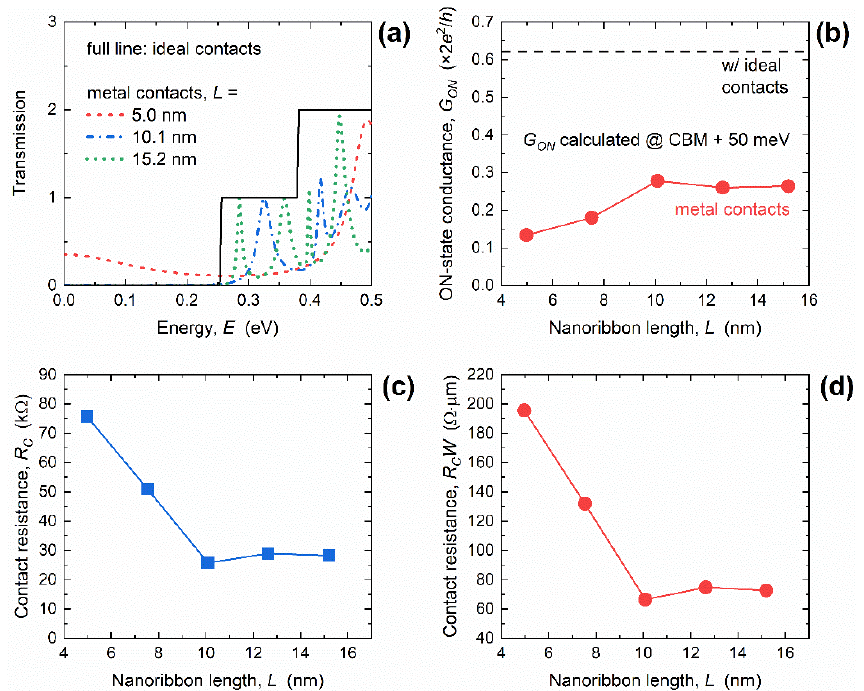
Figure 6. ( a ) Length-dependent transmission in GNRs with ICs and MCs. Impact of length scaling on ( b ) ON-state conductance, ( c ) contact resistance, and ( d ) width-normalized contact resistance. In all cases, W = 2.6 nm.